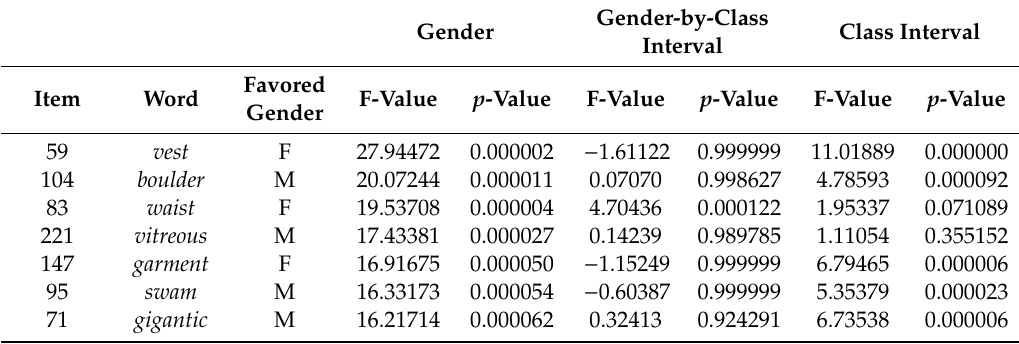
Table 1. Items with di ff erential item functioning (DIF) before the resolving process ( α = 0.05; with Bonferroni correction: α = 0.000081).